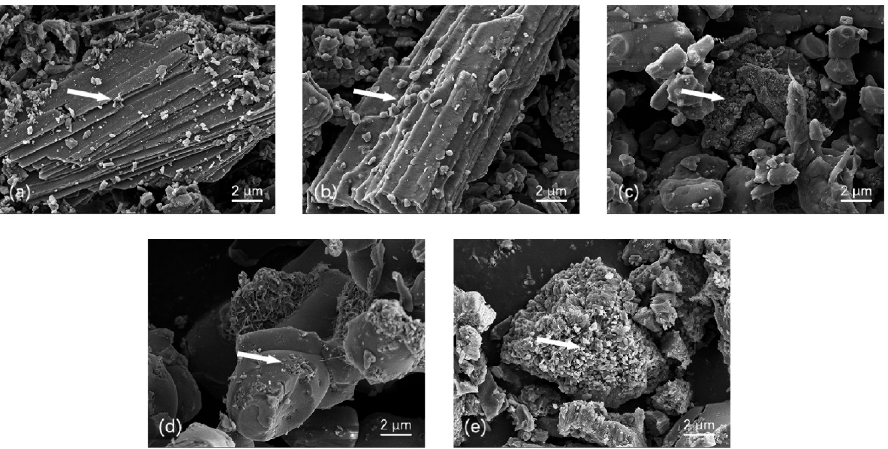
Figure 2. SEM images of pre- and post-calcined OSP. ( a ): Inactivated OSP; ( b – e ): 5COSP, 6COSP, 7COSP, and 8COSP (OSP after calcination for 2 h at 500, 600, 700, and 800 °C, respectively).